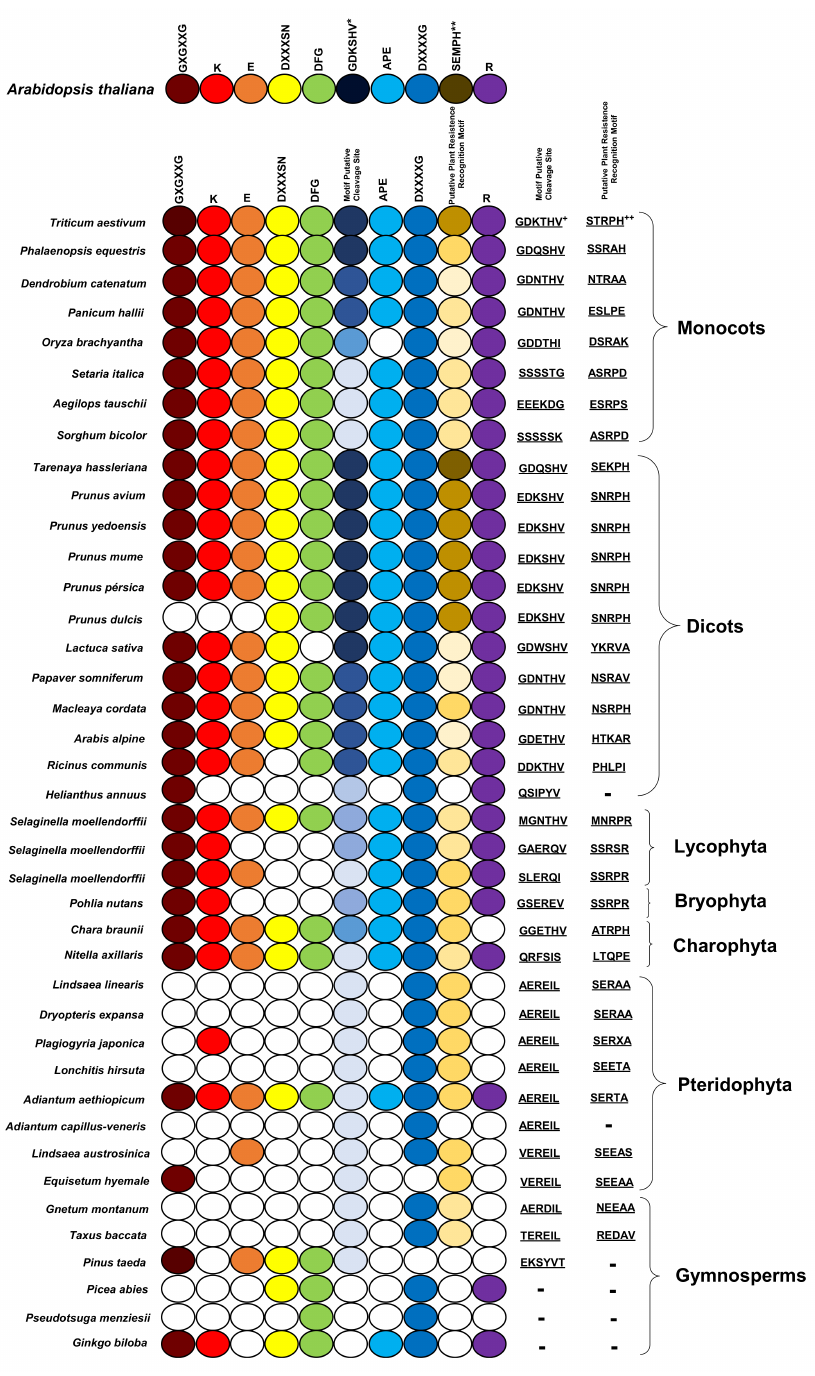
Figure 4. Comparison of conserved kinase subdomains and motifs in PBS1 orthologs in terrestrial plants. Forty sequences from PBS1 orthologs in terrestrial plants were analyzed. Sequences were compared with Arabidopsis PBS1. Selected monocot, dicot, bryophyte, lycophyte, and chlorophyte species harbor most of the kinase subdomains, but these are more variable; in gymnosperms and pteridophytes, the kinase and motif subdomains are less conserved. Color keys are as in Figure 1. The putative motif cleavage site is indicated with a dark blue circle, the blue hue decreasing if there is one or more amino acid changes relative to the motif indicated in Arabidopsis. The same applies to the putative plant resistance recognition motif but in dark yellow. White circles indicate the absence of a subdomain or motif. All motif putative cleavage sites and putative plant resistance recognition motifs identified are listed in Supplementary Table S1. *, ** Motifs are taken as a reference for the analysis. + , ++ Motifs with greater abundance in different species; see Supplementary Table